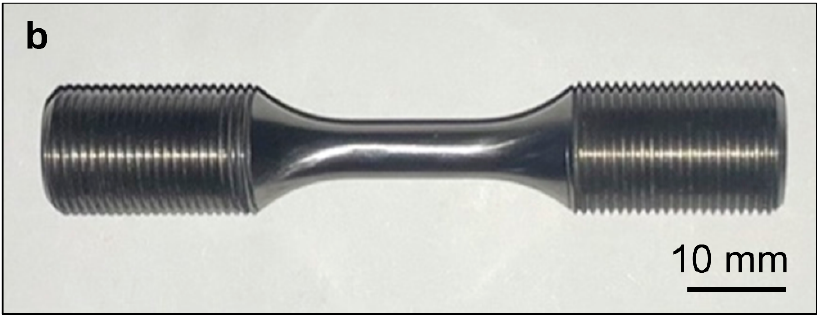
Figure 2. The schematic illustration ( a ) and macrograph ( b ) of specimens for the strain-controlled fatigue test (unit: mm).